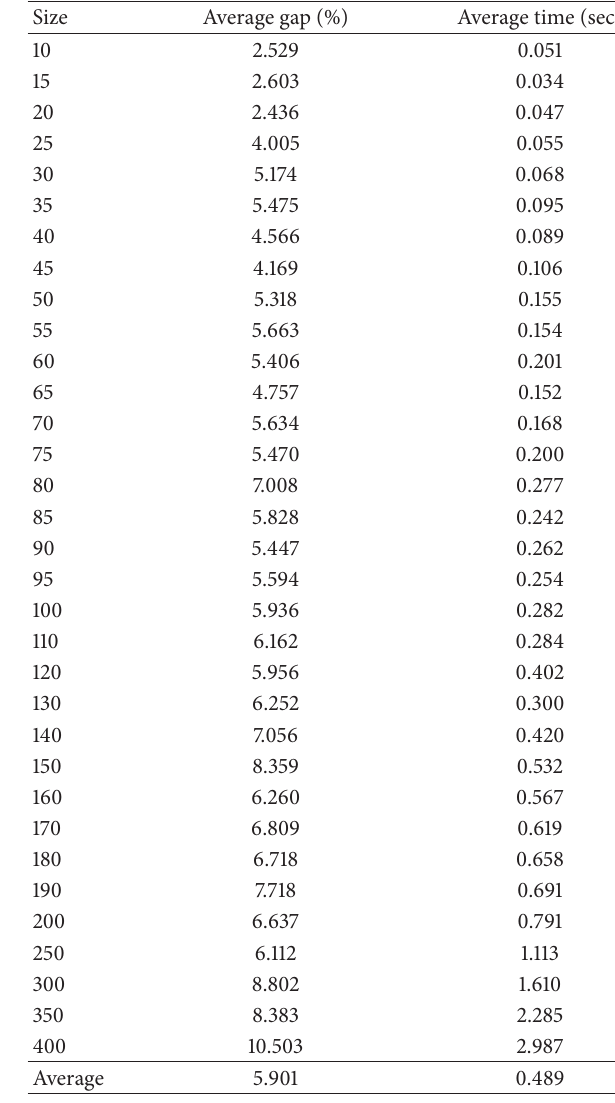
Table 3: Results of the split correction heuristic. Table 4: Results of the optimal correction